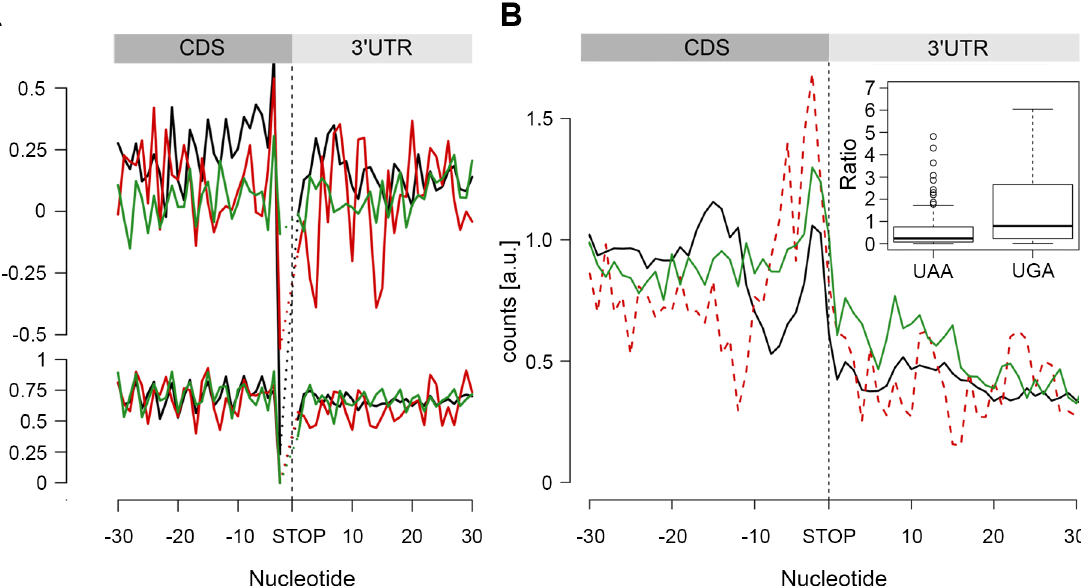
Fig 5. The stop codon of operon genes is more structured than non-operon genes. (A) Average PARS score and GC content for each position of genes terminating with UAA (black), UAG (red) and UGA (green) stop codons. (B) RPF coverage around the stop codon region for genes terminated by UAA (black), UAG (dashed red) and UGA (green) stop codons. Only genes with coverage over 60 reads (S4D Fig) were used; overlapping operon genes were excluded. Note, that UAG-terminated genes are included only for comparison; their low number prevents performing any statistical analysis. The inset shows, for both UAA- and UAG-terminated genes, the ratio between the RPFs downstream of the stop codon (3 to27 nt) and a mean of the CDS. The readthrough value for the majority of the genes was zero; only genes with a value higher than zero are plotted.